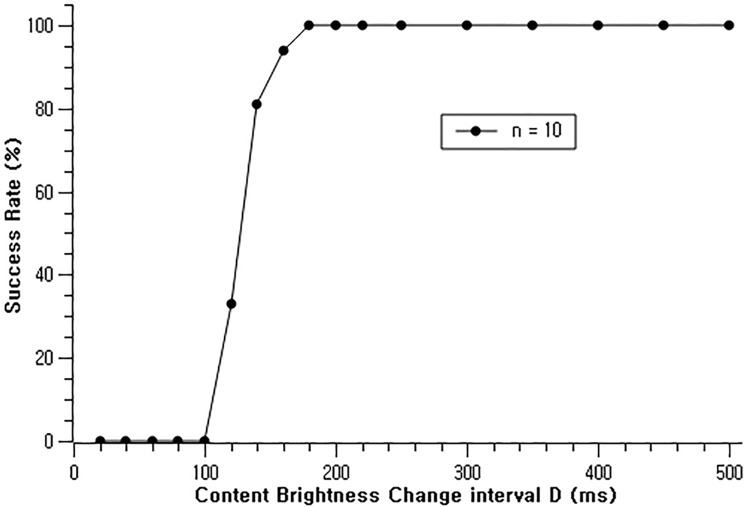
Illumination interval and the recognition rate.